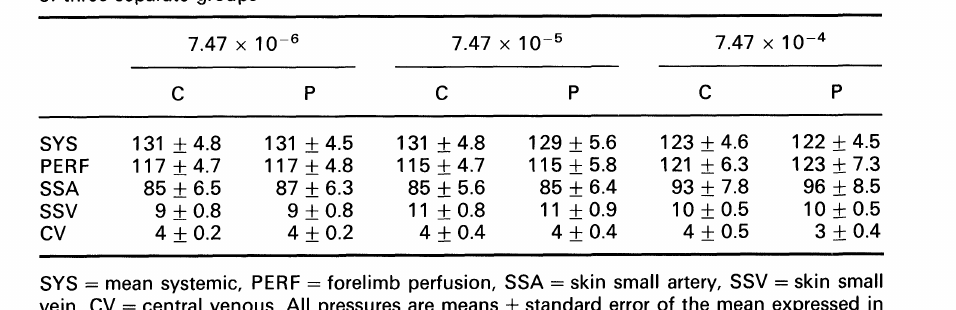
Table 1. Effect of intralymphatic PAF infusion on vascular pressures, n